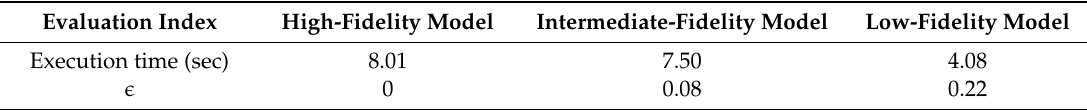
Figure 7. High-, intermediate-, and low-fidelity model design for the dynamic system: An example of a UUV surfacing simulation. Table 1. Execution time and error of high-, intermediate-, and low-fidelity models for a UUV surfacing simulation.